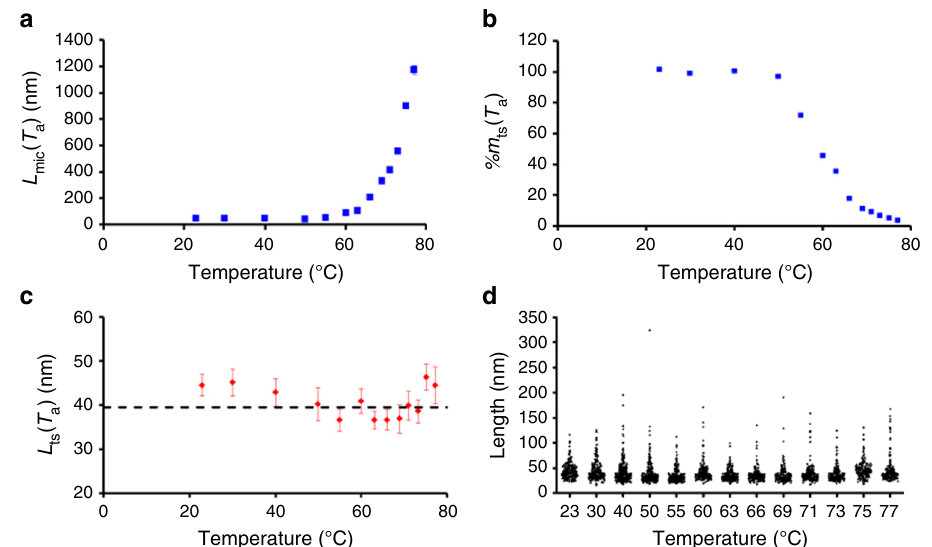
Fig. 2 Effect of the dissolution temperature on the length and number of surviving seeds. a Evolution of the number average length of the PFS 53 - b -PI 637 seed crystallites regrown at 23 °C as a function of annealing temperature (control experiment). b Evolution of the apparent mass percentage of surviving seeds as a function of annealing temperature. c Evolution of the length of the surviving seeds as a function of annealing temperature. The horizontal dashed line corresponds to the average length of the trapped seeds (averaged over the whole annealing temperature range). Error bars correspond to the s.e.m. of the length distributions determined by tracing more than 200 stained trapped seeds for each annealing temperature (see Supplementary Methods). d Length distributions of the surviving seeds at each annealing temperature. The surviving seeds were trapped by the addition of PFS 60 - b -PDMS 660 prior to cooling, and stained with Karstedt ’ s